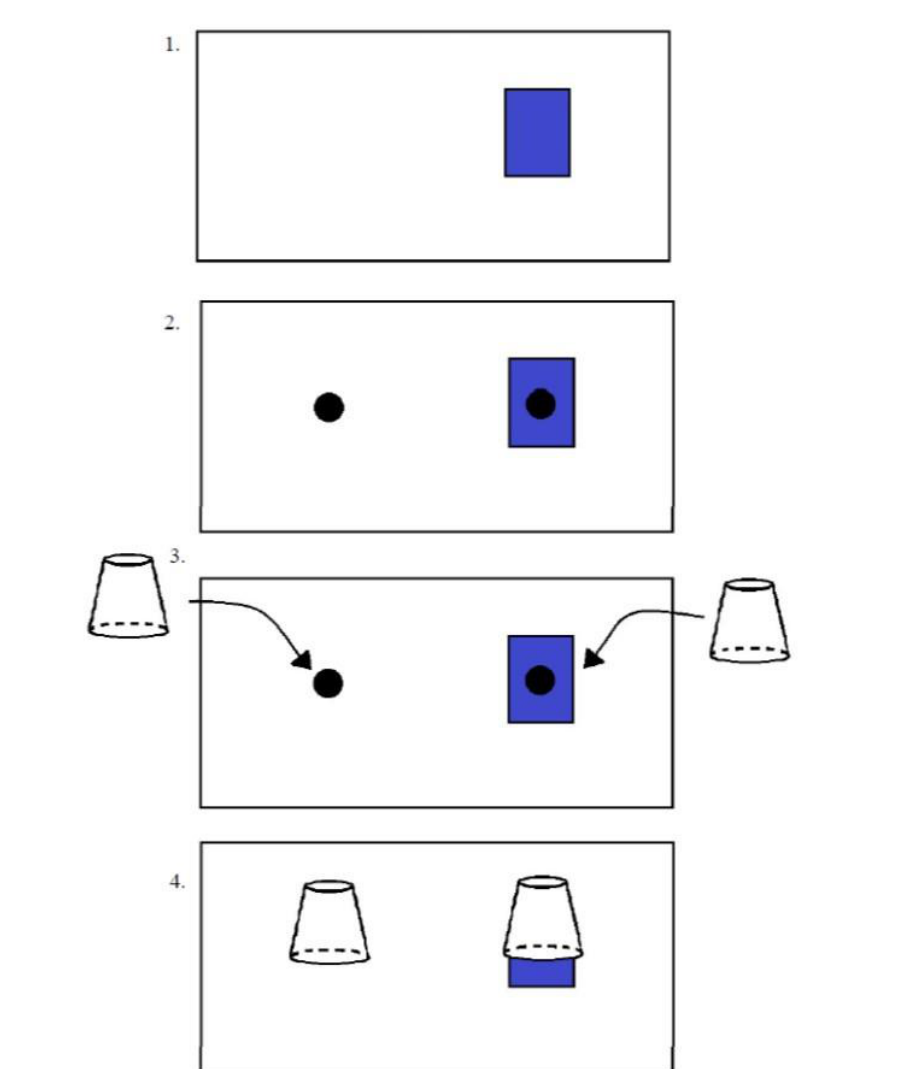
Schematic of the Trap Cups